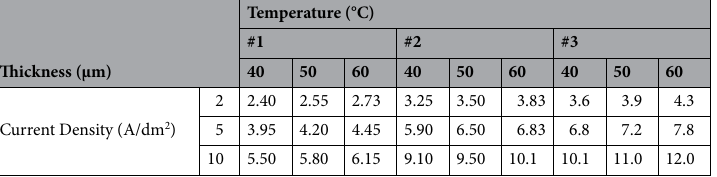
Table 7. Simulated final thickness of the electroplated cathodes #1, #2, and #3 after a fixed time of 30 s.